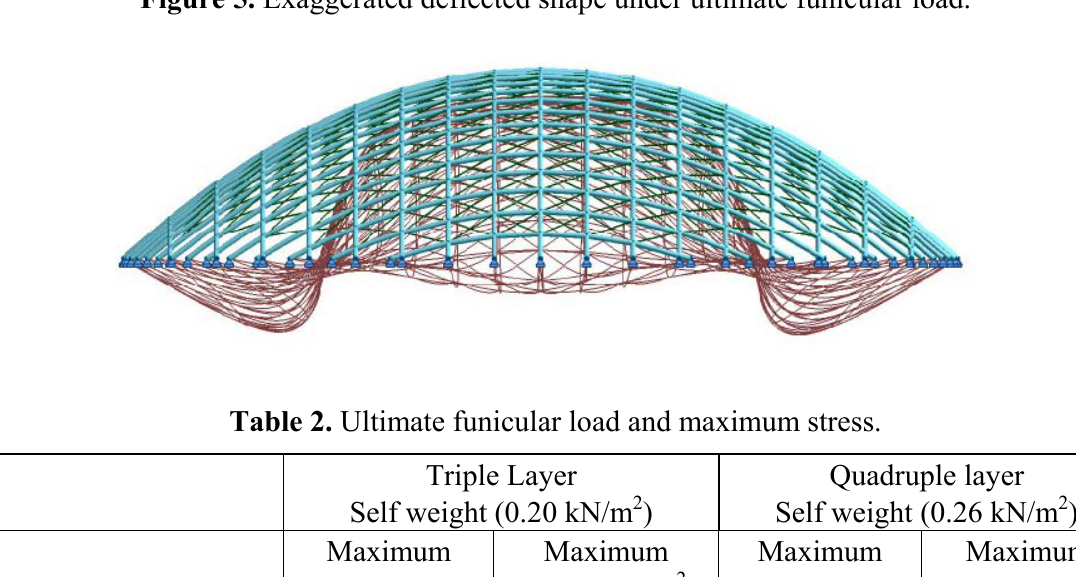
Figure 5. Exaggerated deflected shape under ultimate funicular load.